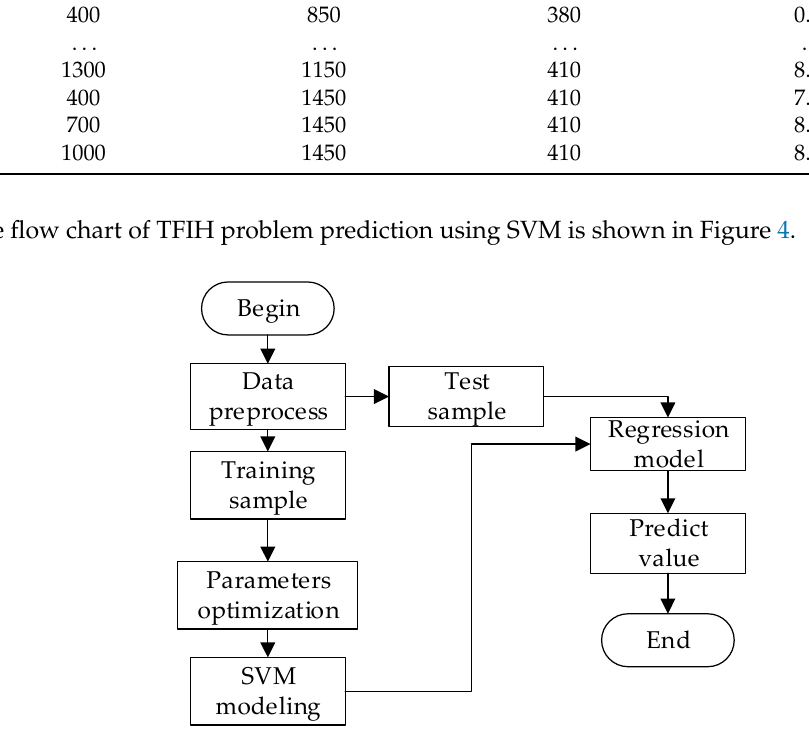
Figure 4. Flow chart of SVM used for the TFIH problem prediction.